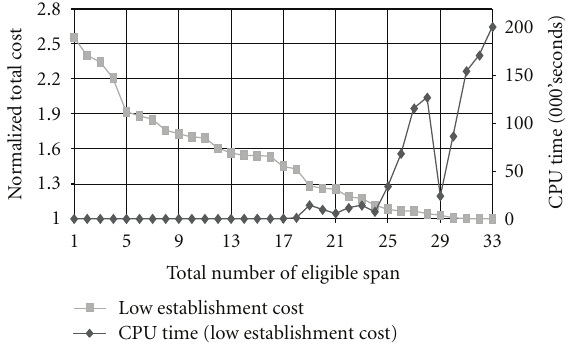
Figure 7: Total network costs and CPU time versus the number of eligible spans for the 35-node network.